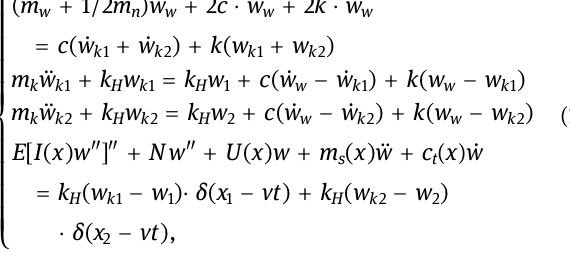
Table 1: Mechanical parameters of one bogie ( per ½ track ) –